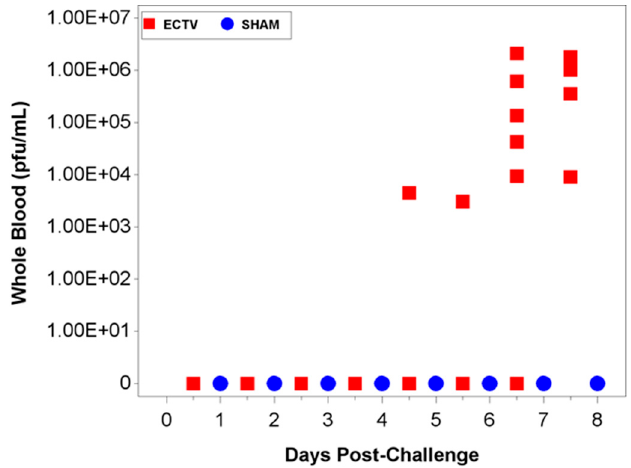
Figure 7. Viremia as measured by plaque assay. The first positive viremia titers via plaque assay occurred at 4.5 days following ECTV ‐ Mos infection. Titers varied from 10 3 (4.5 days PI) to 10 6 PFU/mL (7.5 days PI).